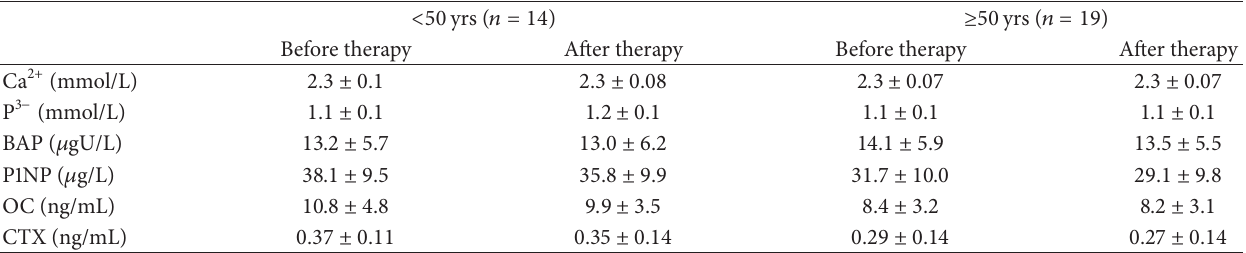
Table 3: Subgroup analyses of bone turnover after pioglitazone treatment in male patients with type 2 diabetes. < 50yrs ( 𝑛 = 14 ) ≥ 50yrs ( 𝑛 = 19 ) Before therapy After therapy Before therapy After